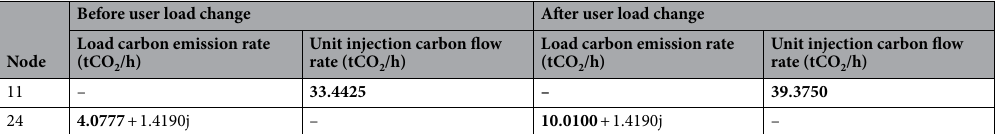
Table 10. Load carbon emission flow rate and unit injected carbon emission flow rate. Significance values are in